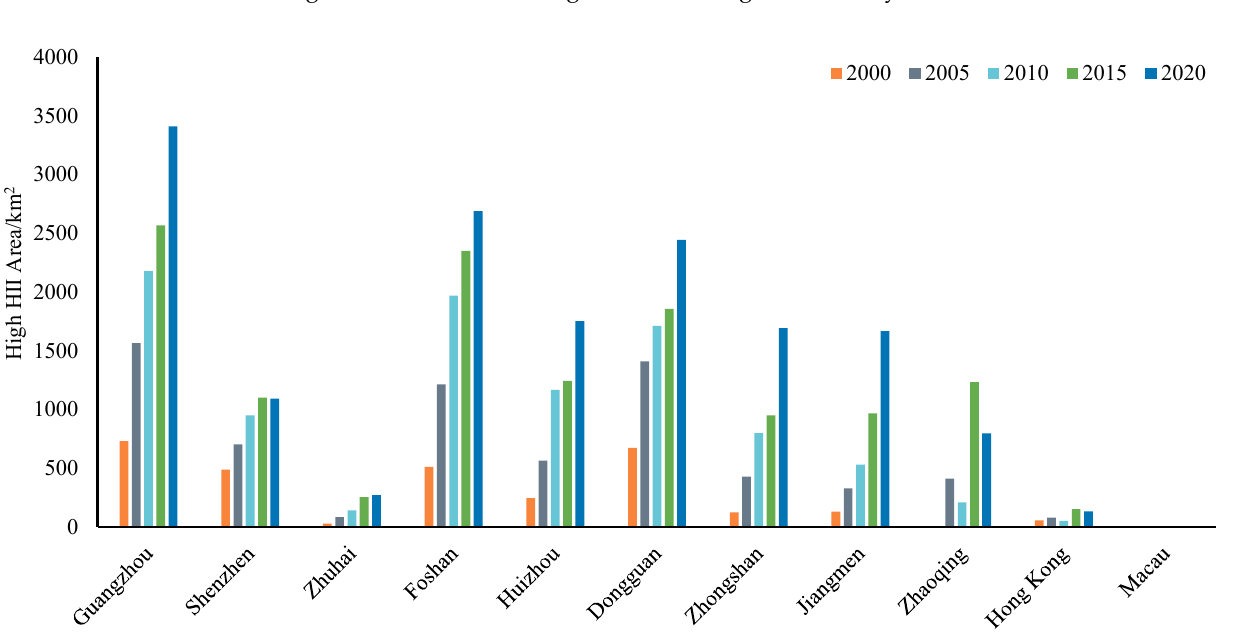
Figure 6. The changes in the high heat island area in eleven cities of GBA from 2000~2020. The differences in changes in urban heat islands in various cities also reflect the development process and urbanization of these cities in the Greater Bay Area. Macau and Hong Kong are developed-cities, with high levels of urbanization and strict ecological and environmental protection. Therefore, the urban heat island effect is relatively stable. The Shenzhen Special Economic Zone has a relatively small area; its development started earlier and matured. Therefore, the urban heat island effect has not changed much in the past five years. Furthermore, Zhuhai has a similar situation to Shenzhen.